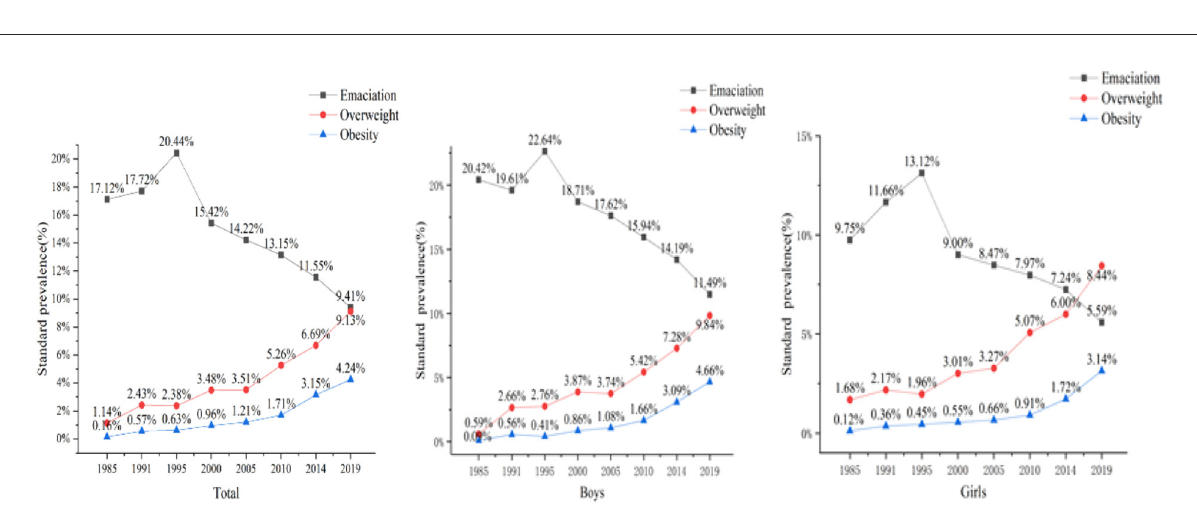
FIGURE2 Age-standardized prevalence of emaciation, overweight, and obesity among school-aged children in total and different genders from 1985 to